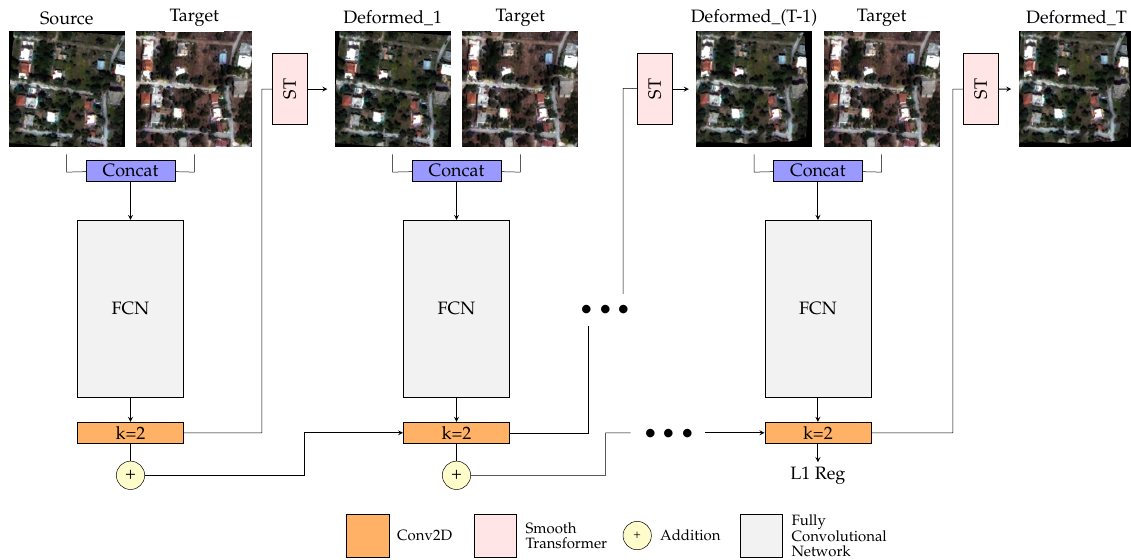
Figure 1. The proposed multistep deformable registration approach. At every time step t , the current transformation parameters are added to the transformation parameters of the previous time step t − 1. Through this iterative process, the network learns to properly refine the initial spatial gradients, providing more accurate deformation